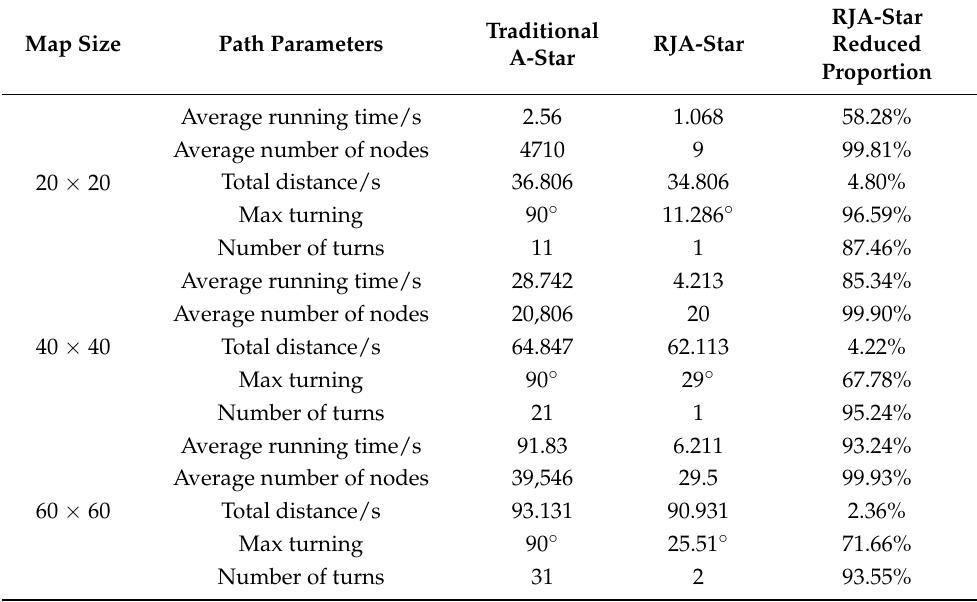
Table 2. Comparison of experimental data of three different specifications of network